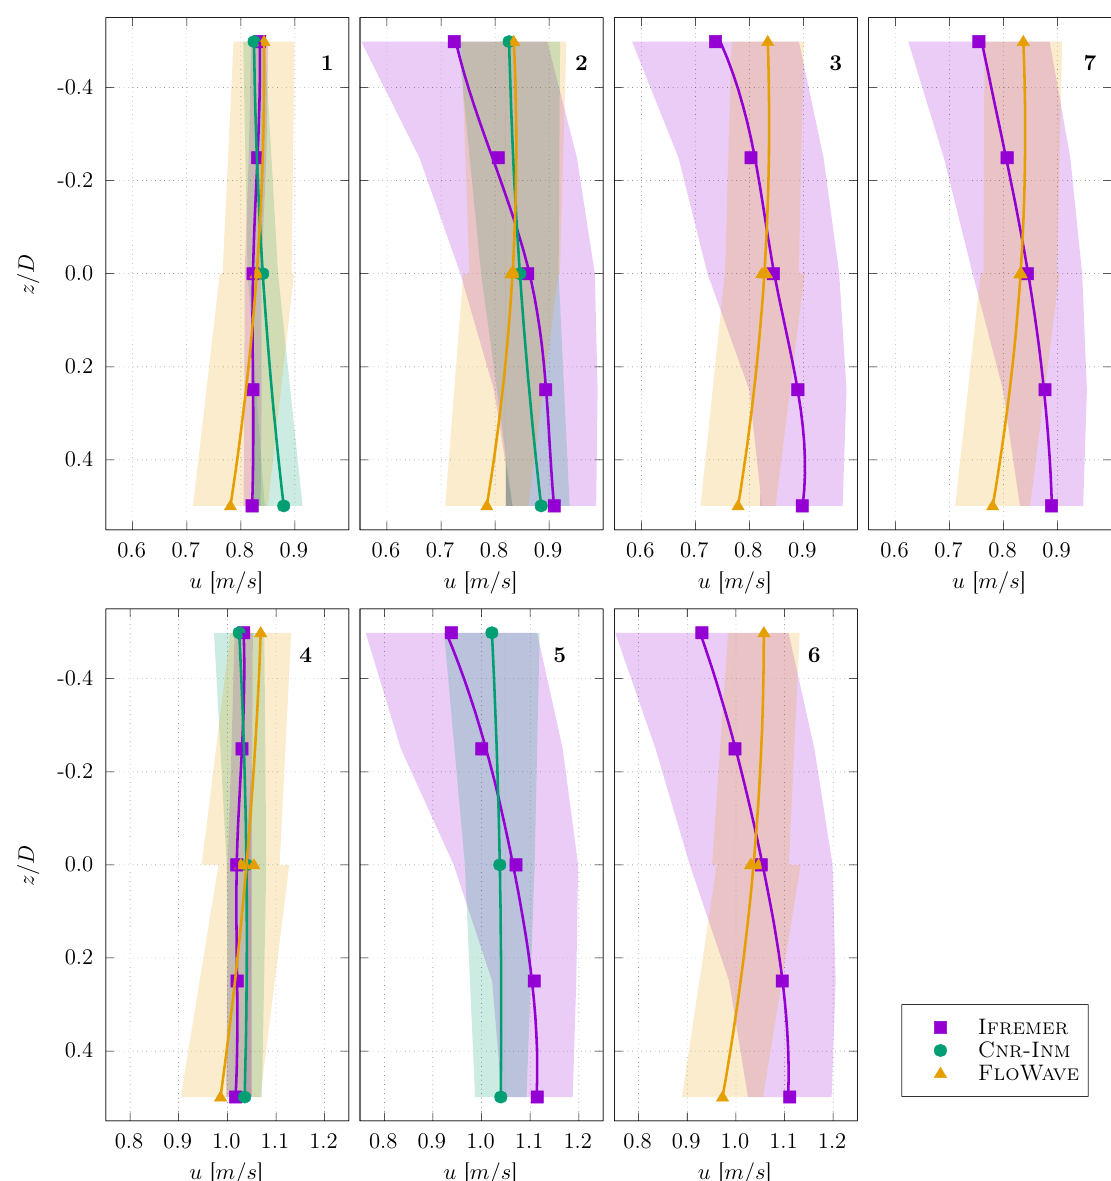
Figure 8. Vertical profiles of the average and standard-deviation of the stream-wise component of the velocity at the turbine location. Numbers 1 to 7 stand for the 7 different generated test cases (see Table